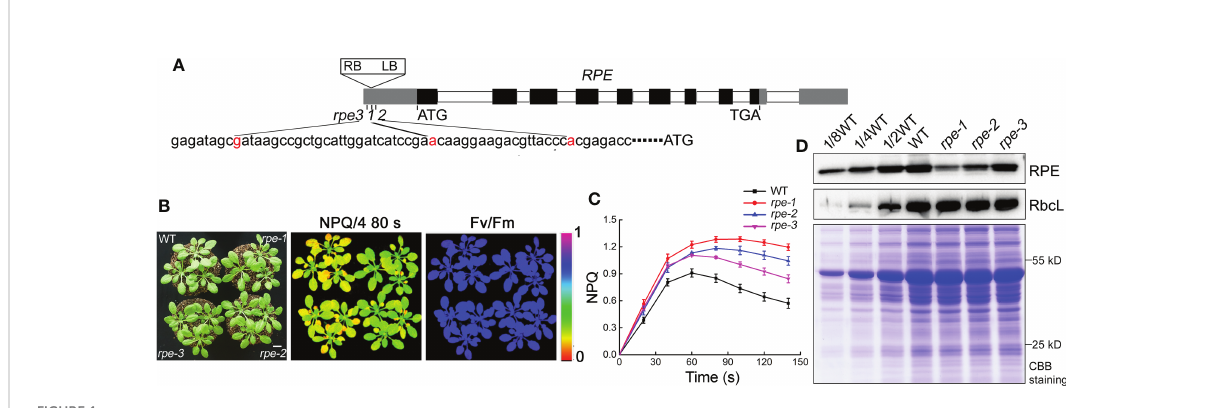
FIGURE 1 Characterization of the rpe mutants. (A) Schematic representation of RPE . The positions of the T-DNA insertions in the three rpe mutants are shown with red nucleotides. (B) Growth, NPQ, and Fv/Fm phenotypes of WT and rpe mutants. Four-week-old plants grown on soil at 50 m mol photons m -2 s -1 (left panels). Signal intensities for NPQ and Fv/Fm are indicated according to the color scale (0 to 1.0) on the right. The bar represents one centimeter. (C) NPQ induction curves of the rpe mutants and WT. NPQ was calculated as (Fm-Fm ’ )/Fm ’ . Data are presented as the means ± SD (n=4). (D) Immunoblot analysis of RPE protein in the rpe mutants. Chloroplast stroma was isolated and immunoblot analyses were performed. RbcL was used as loading control. Equal amounts of chloroplast stromal proteins were loaded on the gels. The gels were stained with CBB for visualization of the